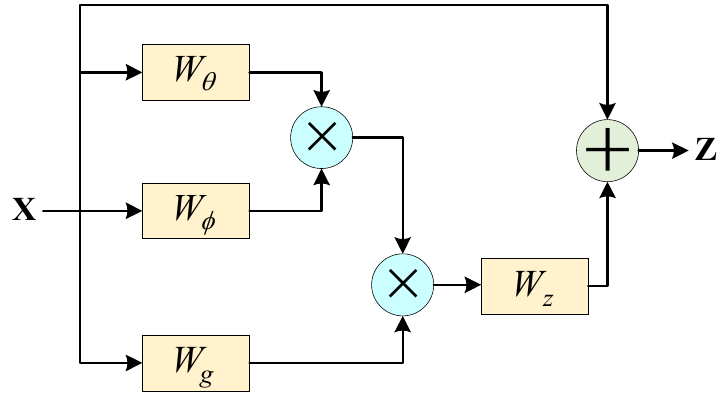
Figure 8. A Non-local network. W θ , W φ , W g and W z are weight matrices to be